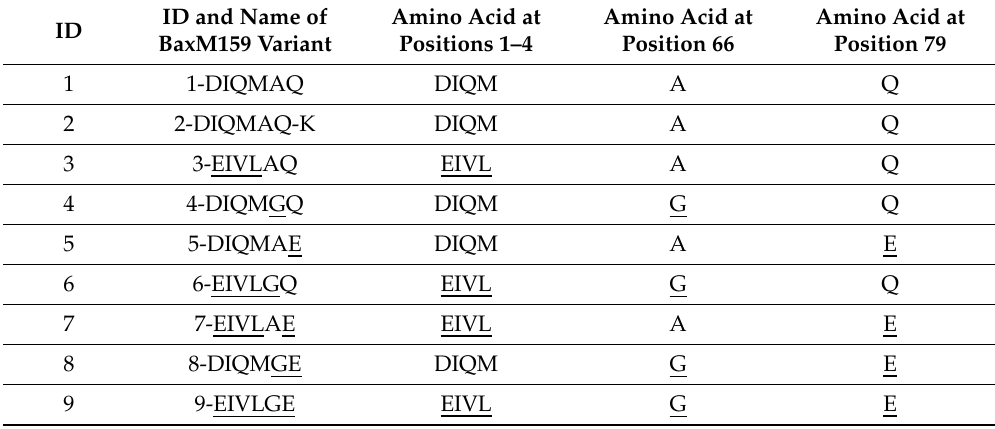
Table 1. BaxM159 variants. Underlined amino acids in the BaxM159 variant name indicate amended amino acids in positions 1–4, 66, and 79. C-terminal lysine is removed unless K indicates presence of C-terminal lysine. Antibodies 1-DIQMAQ and 2-DIQMAQ-K represent the parental antibody. Amino acid numbering is indicated according to kabat